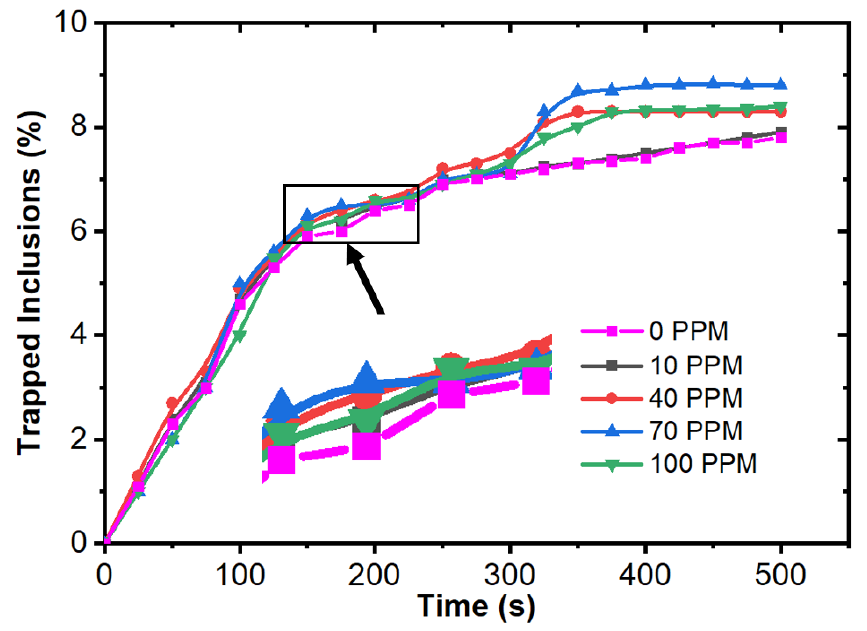
Figure 14. Trapped inclusions near the solid–liquid boundary in the mold at different sulfur con- centrations.